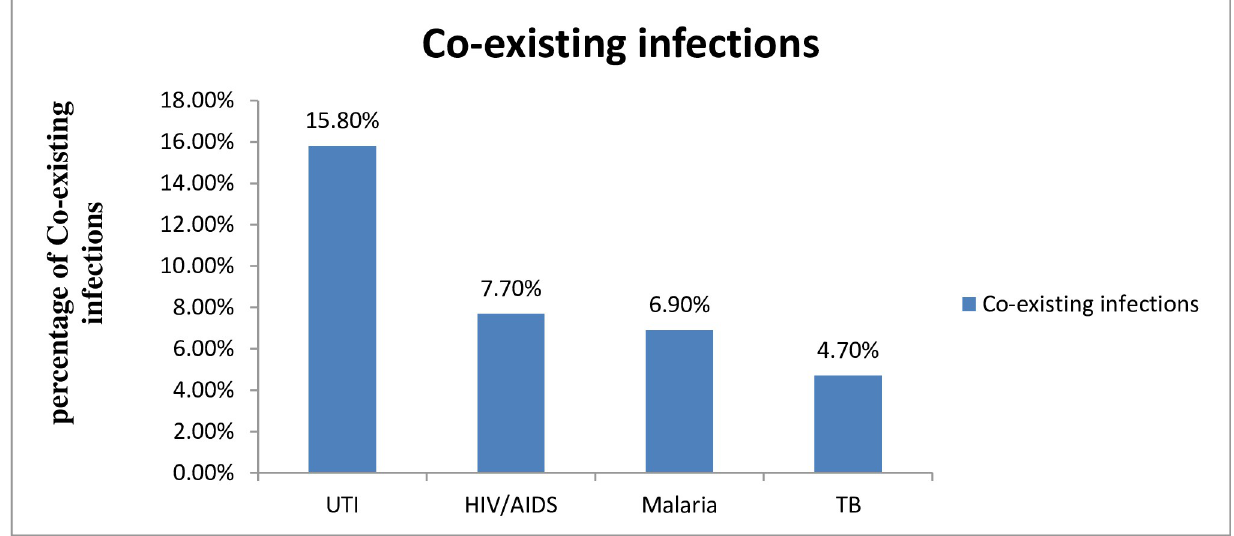
Fig 1. Magnitude of co-existing infection among immediate postpartum women in the East Gojjam zone hospitals Northwest Ethiopia 2020.